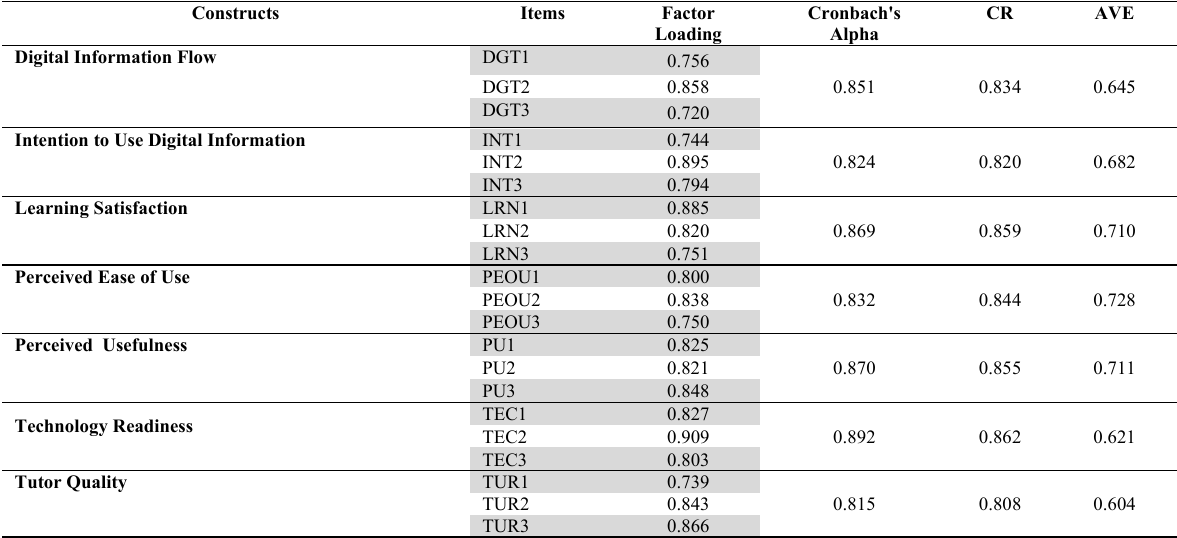
Convergent validity results which assures acceptable values (Factor loading, Cronbach’s Alpha, composite reliability, Dijks- tra-Henseler's rho ≥ 0.70 & AVE > 0.5).